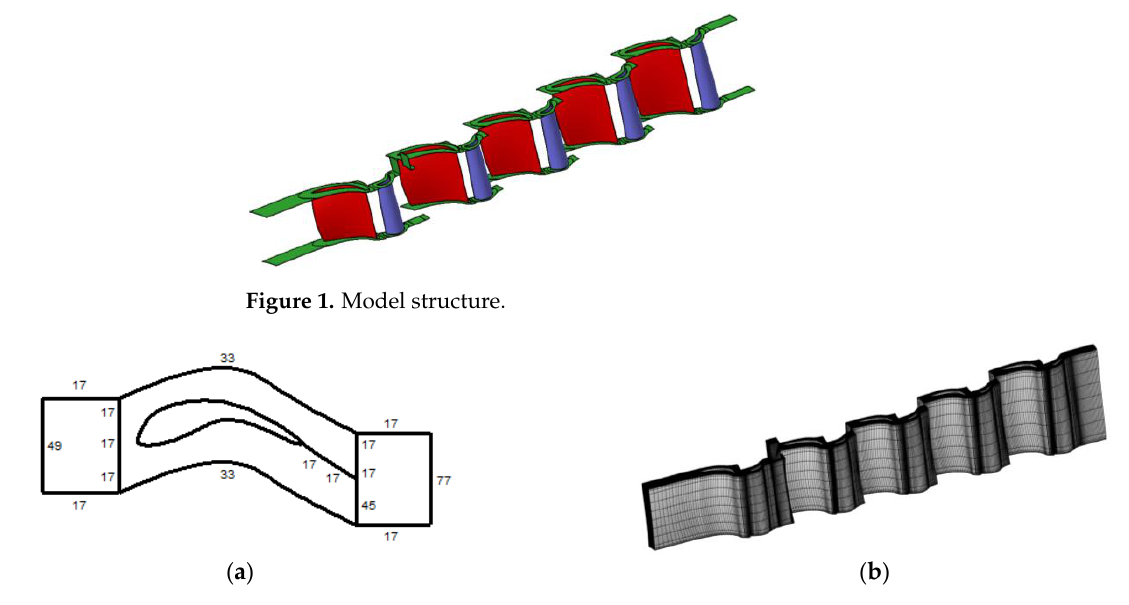
Figure 2. Schematic diagram of model mesh: ( a ) H-O-H topology; ( b ) computational grid.